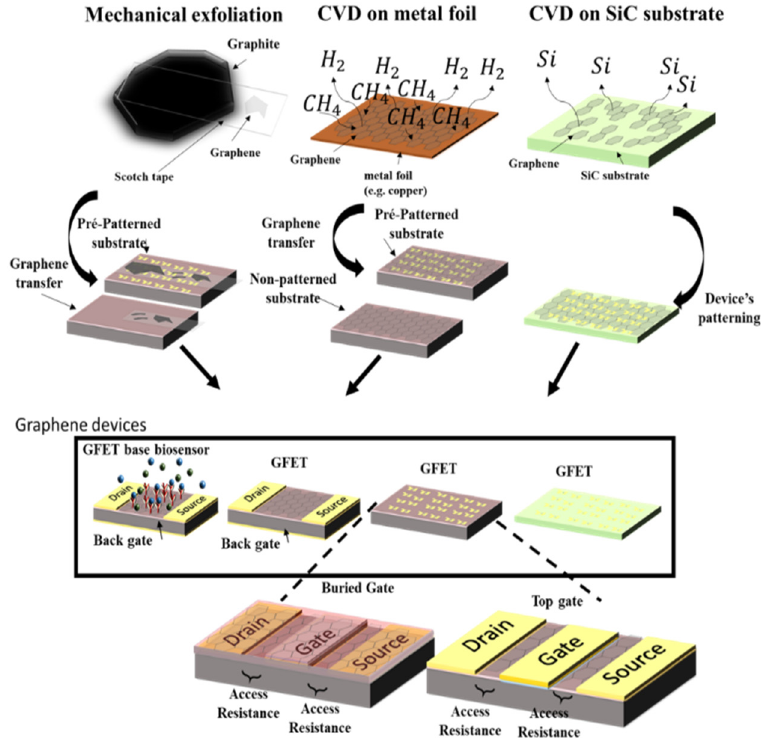
Figure 5. General fabrication steps of GFET-based devices.